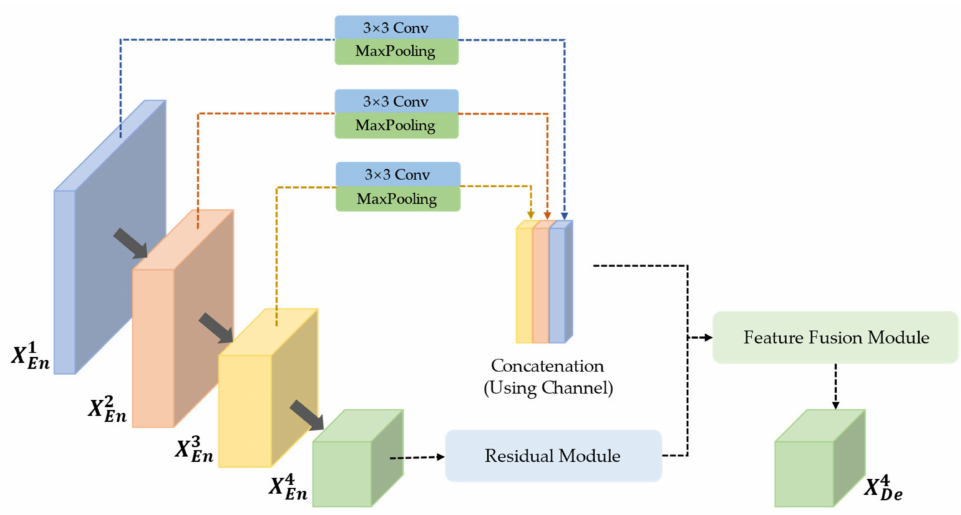
Figure 6. Illustration of how to construct a feature map of the fourth decoder layer.